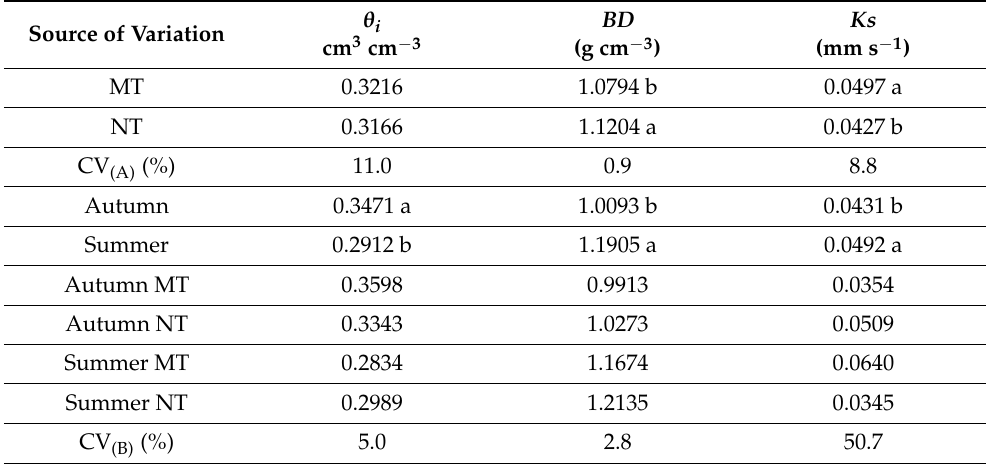
Table 2. Mean separation and coefficients of variation of variables measured in field ( θ i , BD ) and estimated with BEST procedure ( Ks